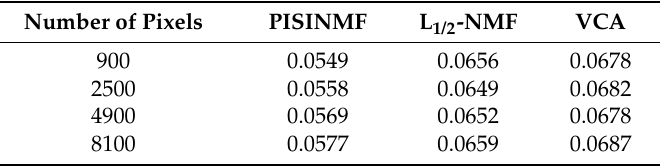
Table 8. RMSE comparison with different numbers of pixels in the scene.